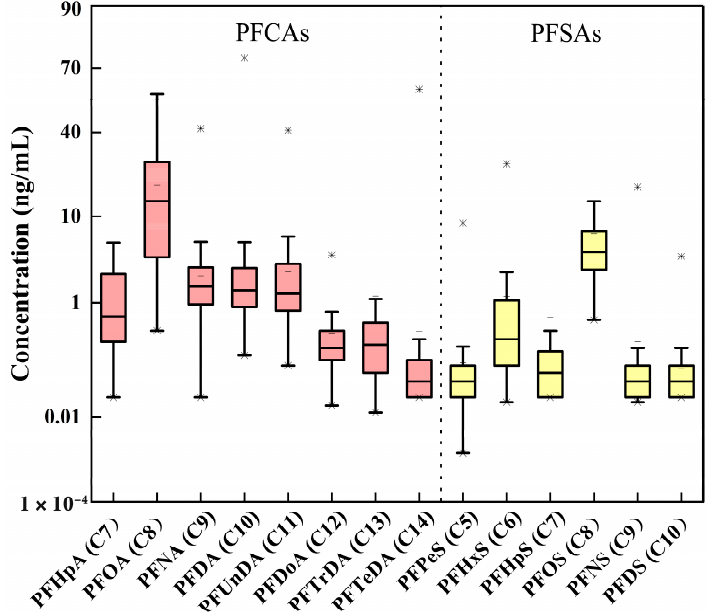
Figure 1. Levels of PFAS (ng/mL) in maternal serum, * means the maximum concentration.